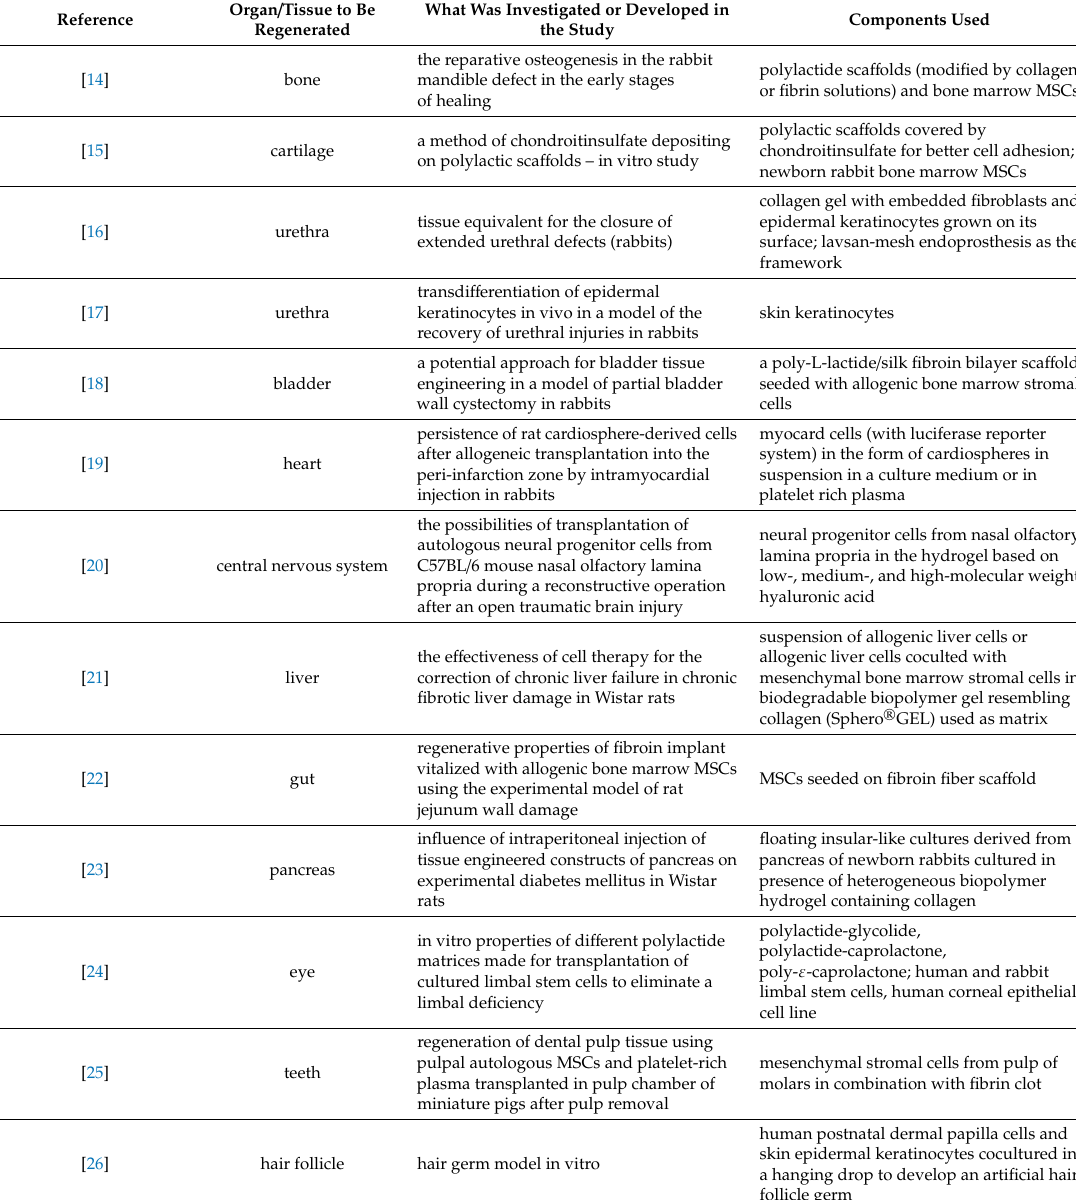
Table 3. Examples of studies on regeneration of di ff erent organs and tissues in Russia in the 2010s.